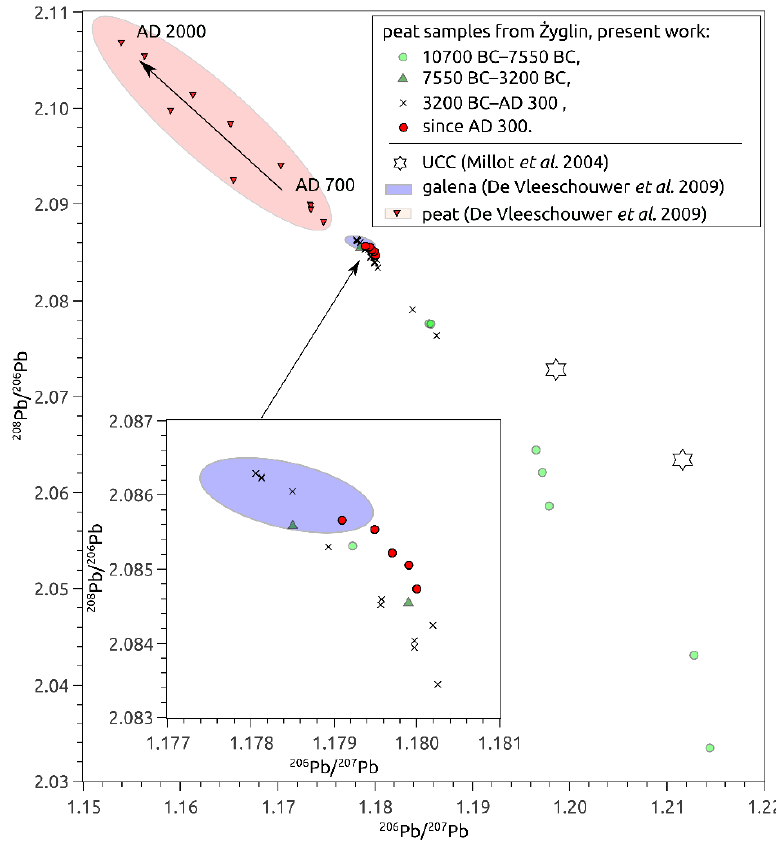
Figure 4. 208 Pb/ 206 Pb versus 206 Pb/ 207 Pb plot for: 23 samples from Żyglin (this work); 11 ombrotrophic peat samples (700 AD–2000 AD) (De Vleeschouwer et al . 2009); 11 galena samples from Chrzanów, Olkusz, Pomorzany (De Vleeschouwer et al . 2009); and Upper Continental Crust (UCC) estimated by Millot et al . (2004). The error bars are significantly smaller than the symbols.